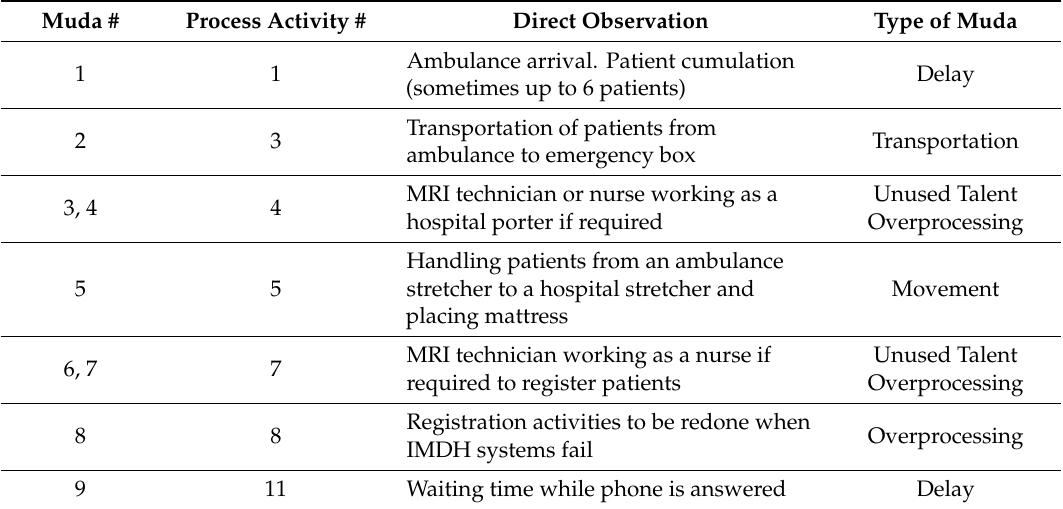
Table A1. Analysis of different types of muda.